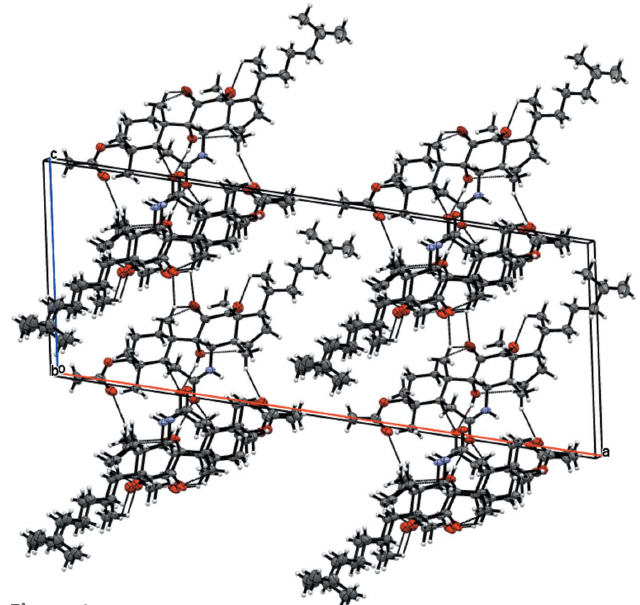
Figure 4 View of the packing of the title compound along [010] showing the formation of C—H (cid:2)(cid:2)(cid:2) O hydrogen-bonded planes and the voids left by , y + 1 , (cid:4) z ) 2 2 symmetry-related methylheptane